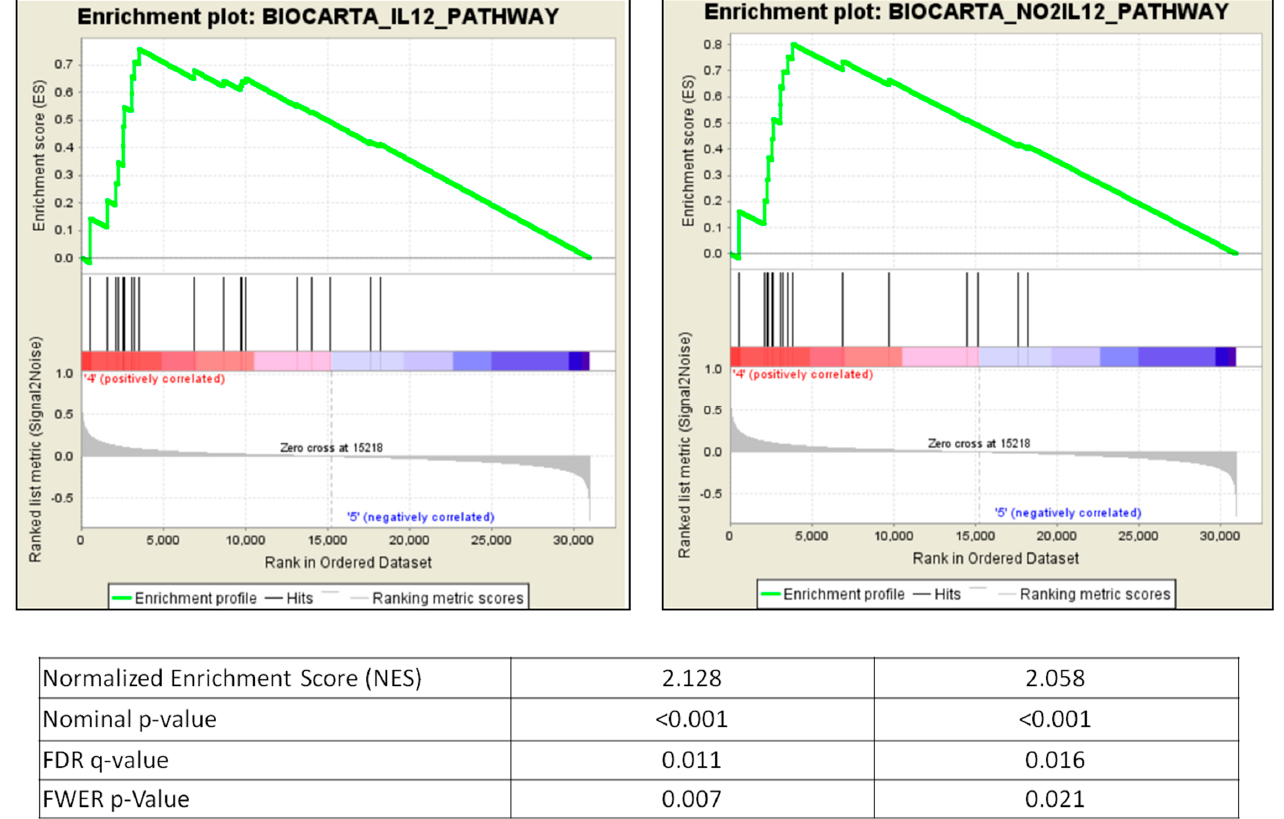
Figure 7. Top 2 most significantly enriched GSEA pathways in BAFF inhibition. Table 3. Most significantly enriched transcripts in GSEA pathways in BAFF group vs. IgG1 CONT.